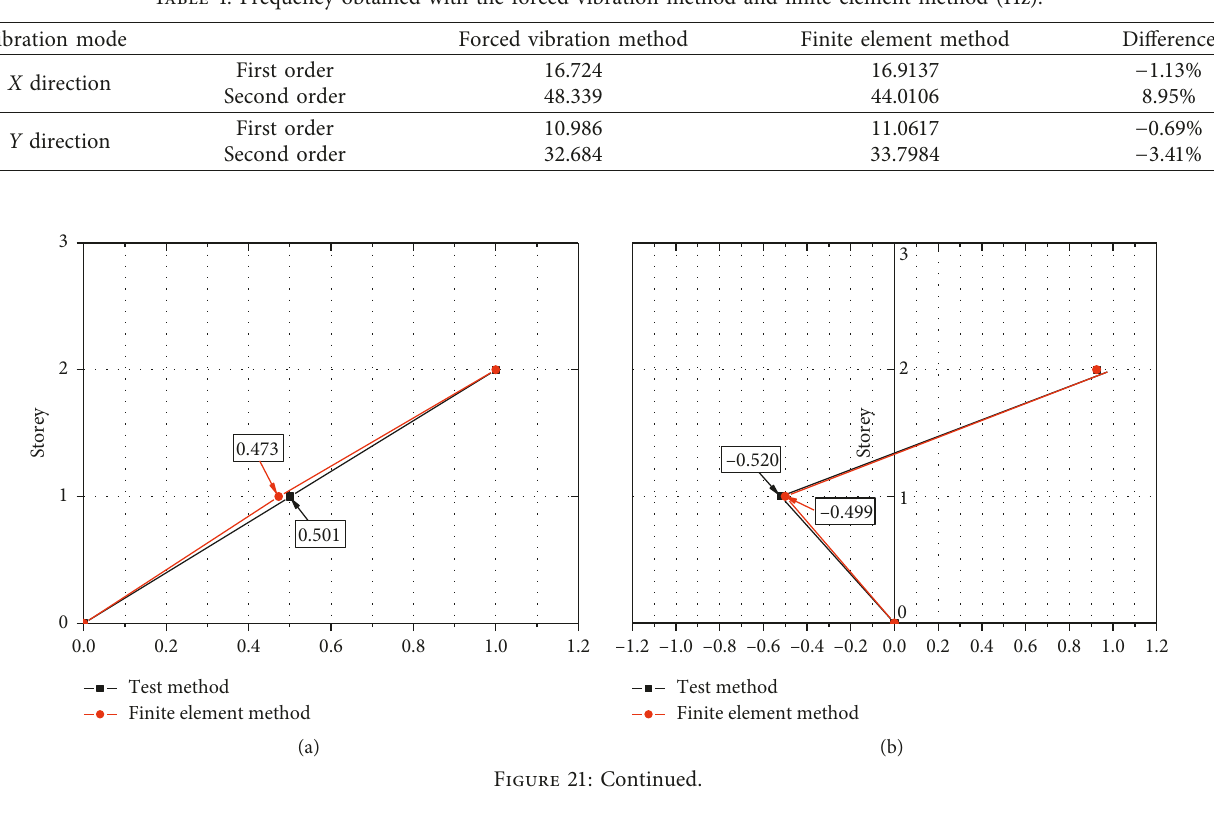
Table 4: Frequency obtained with the forced vibration method and finite element method (Hz).